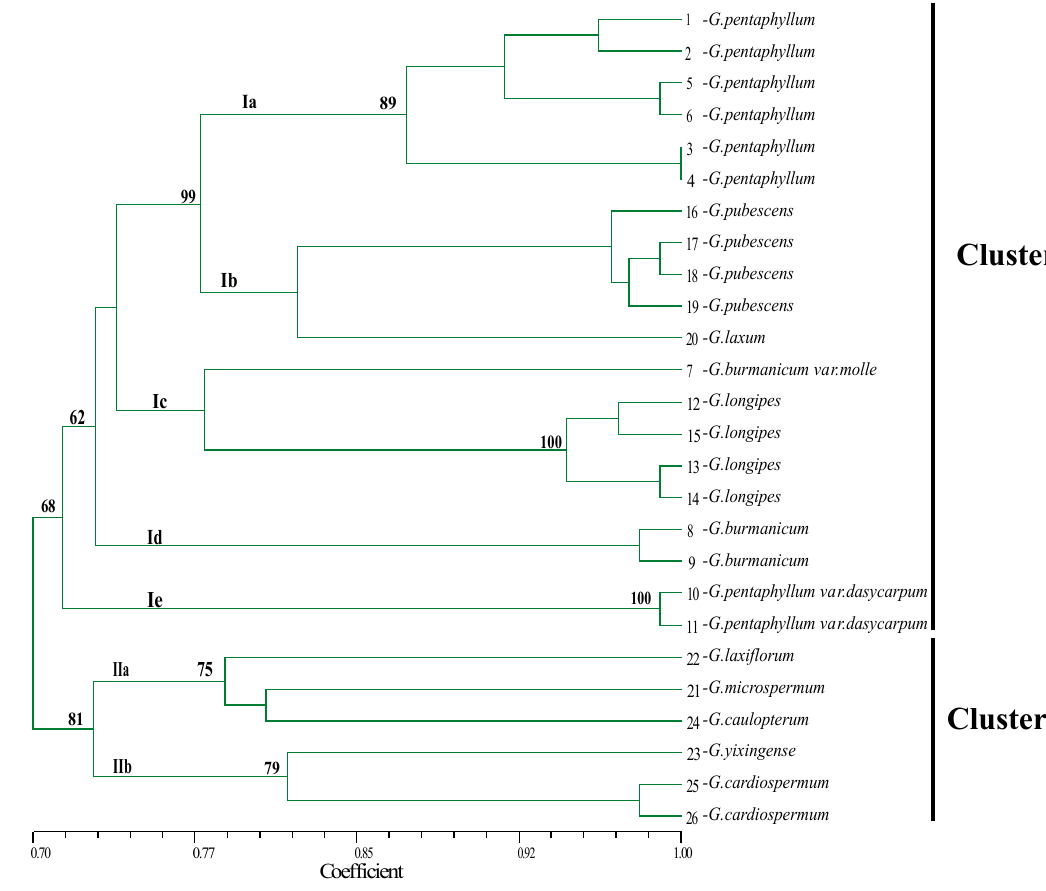
Figure 7. Genetic relationships among Gynostemma species based on EST-SSR markers. Genetic relationships among 26 individual plants. The scale at the bottom of the dendrogram indicates the level of similarity between the genotypes. Bootstrap values (>50) were labeled on the branches from 1000 re-samplings.